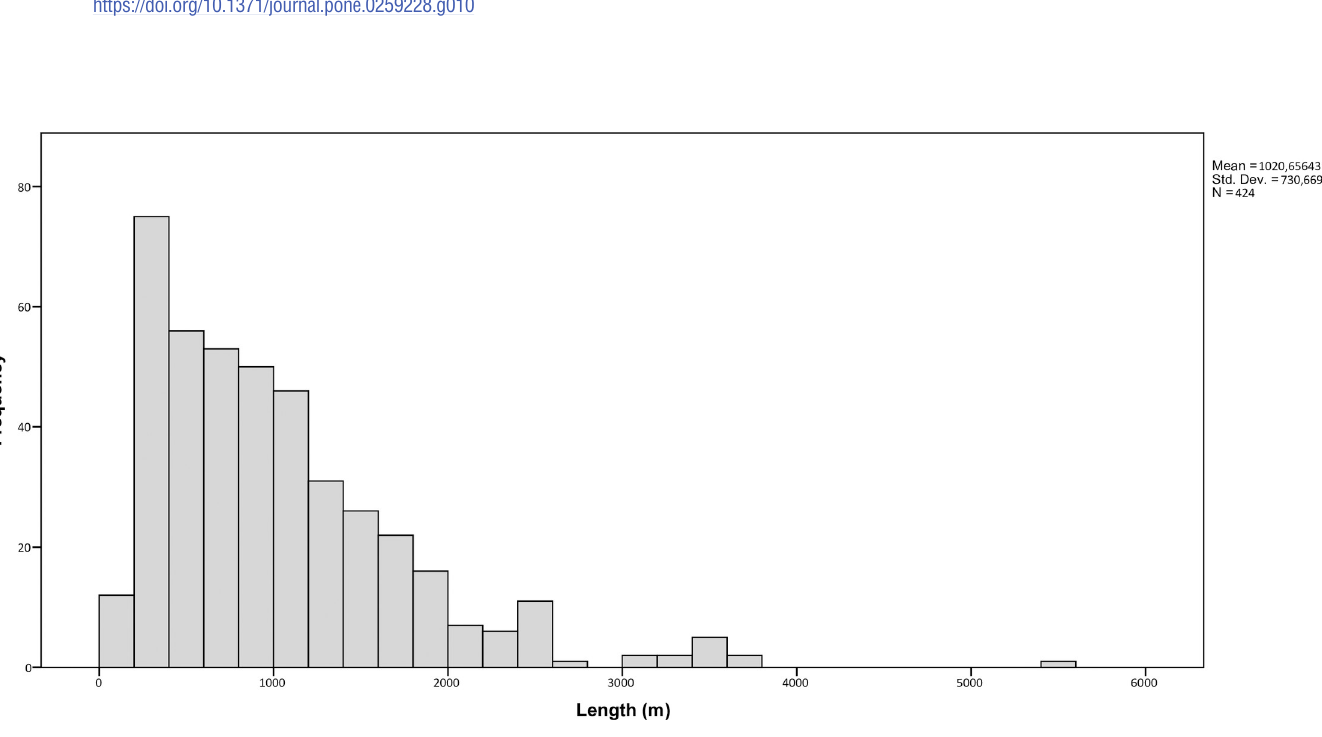
PLOS ONE | https://doi.org/10.1371/journal.pone.0259228 November2, 2021 16 /